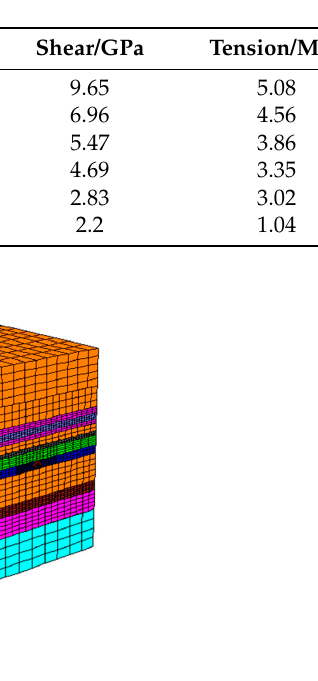
Figure 15. Stress distribution characteristics of the floor after coal seam 16# mining: ( a ) Minimum principal stress (MPa); ( b ) Minimum principal stress (MPa). The following can be seen: (1) The stress concentration occurs under the coal pillar, and an area with a certain range of stress reduction appears under the goaf after mining coal seam 15#. At this time, the minimum principal stress is − 6.0 MPa, and the maximum principal stress is − 17.6 MPa. The maximum principal stress is approximately 2.93 times the minimum principal stress. (2) After coal seams 15# and 16# are mined, the pressure of coal seam 17# is further decompressed, and the stress concentration degree is reduced accordingly. However, the horizontal distance between the roadway and the edge of the coal pillar is 10 m, which is close to the coal pillar. Affected by the stress concentration degree of the coal pillar, the minimum principal stress at the mining roadway axis is − 6.0 MPa, the maximum principal stress is − 18.6 MPa, and the maximum principal stress is approximately 3.1 times the min- imum principal stress. From the surrounding rock stress distribution, it can be known that the maximum principal stress in the direction of the roadway axis of coal seam 17# is approximately three times that of the minimum principal stress, although it belongs to the stress reduc- tion when the roadway is located at a horizontal distance of 10 m from the edge of the pillar. According to the Moore–Coulomb strength criterion, the greater the difference be- tween the maximum principal stress and the minimum principal stress, the more easily